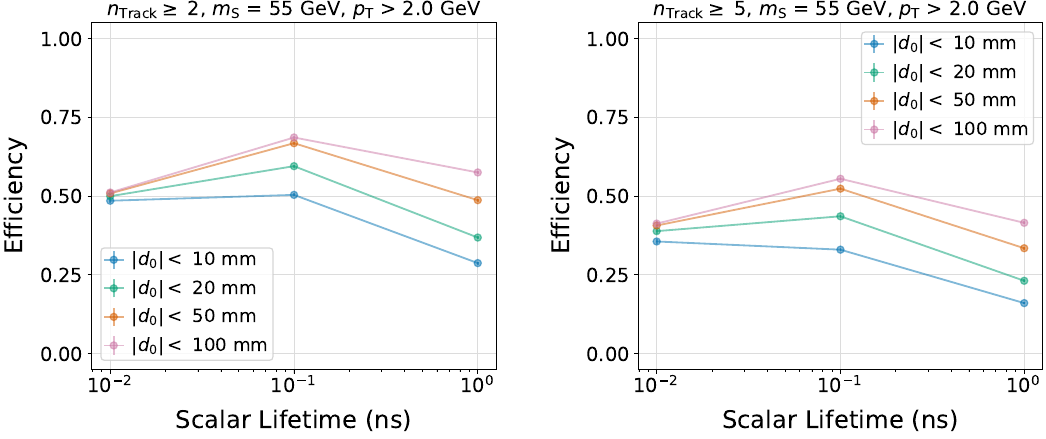
Figure 9. Event-level efficiency as a function of long-lived scalar lifetime for different | d 0 | endpoints and p larger than 2 GeV. Efficiencies are shown for the two (left) or five (right) n T In all cases, the track reconstruction efficiency is assumed to decrease linearly with | d endpoint